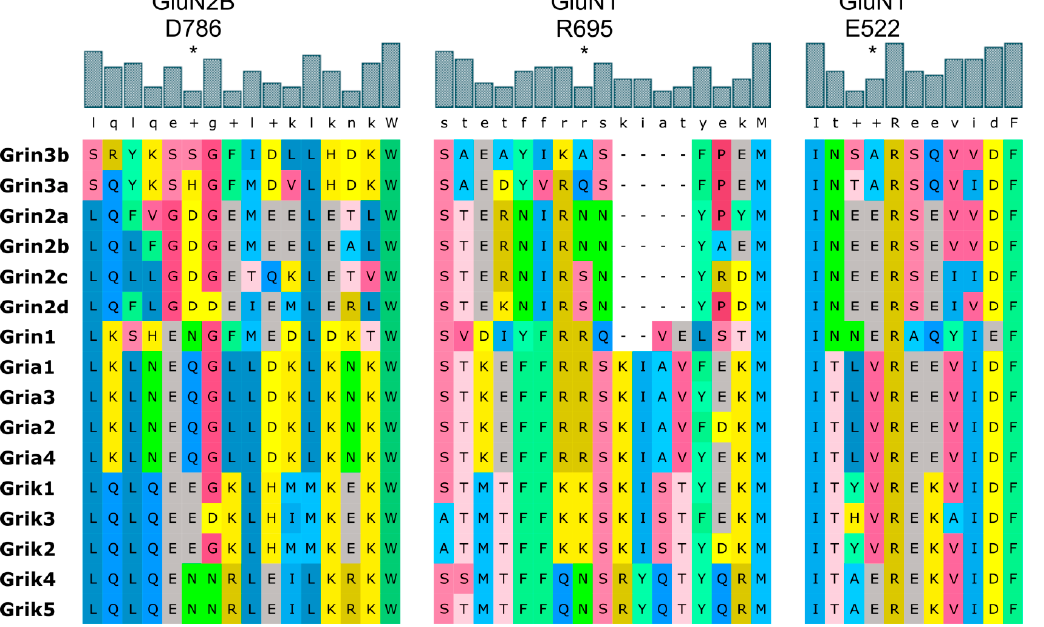
Figure 7. Sequence alignment and conservation of rat iGluRs, showing residues at key LBD interfaces identified from the opening and closing MD simulation of the rat GluN1/GluN2B NMDA receptor. The residues of the Asp–Arg–Glu motif as well as residues in its vicinity showed subunit-specific distribution. The GluN2x subunits can be distinguished by presence of a specific GDG sequence followed by a stretch of negatively charged amino acids.